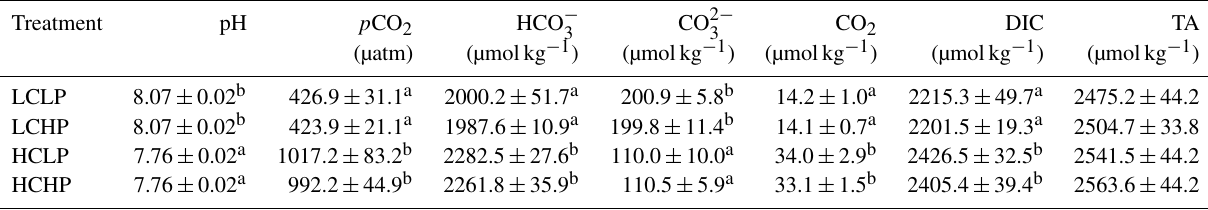
Table 1. Parameters of the seawater carbonate system at different CO 2 and phosphate conditions. Measurements and estimation of the parameters are described in the “Materials and methods” section. Data are reported as means ± SD ( n = 3). LCLP is the low p CO 2 and low P condition, LCHP is the low p CO 2 and high P condition, HCLP is the high p CO 2 and low P condition, and HCHP is the high p CO 2 and P condition. DIC is dissolved inorganic carbon, and TA is total alkalinity.